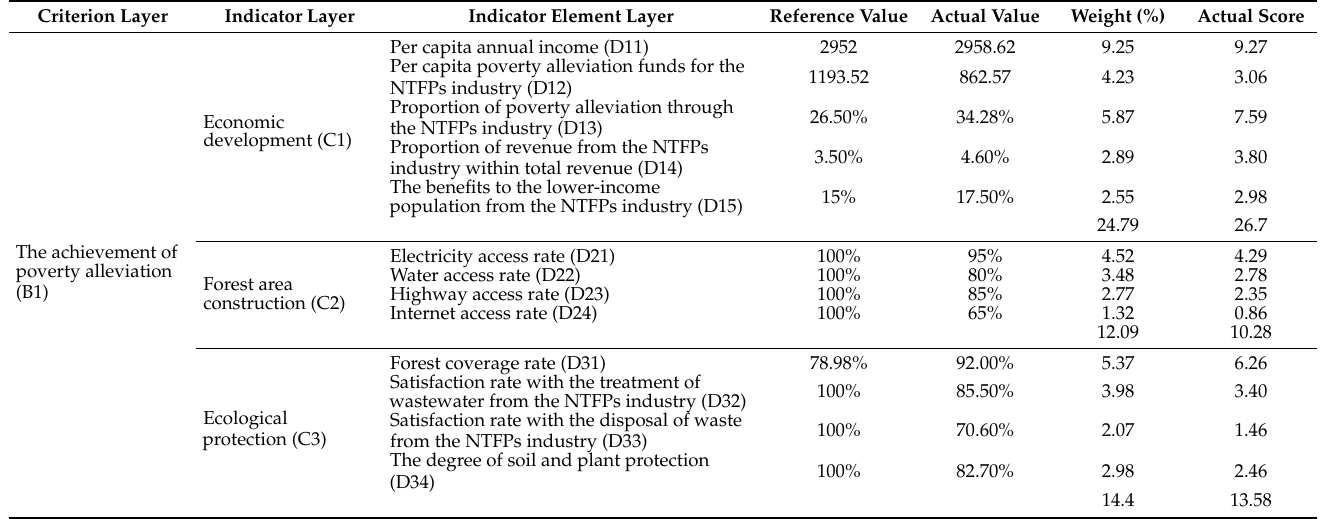
Table 11. The performance evaluation index system for the poverty alleviation performance of the NTFPs